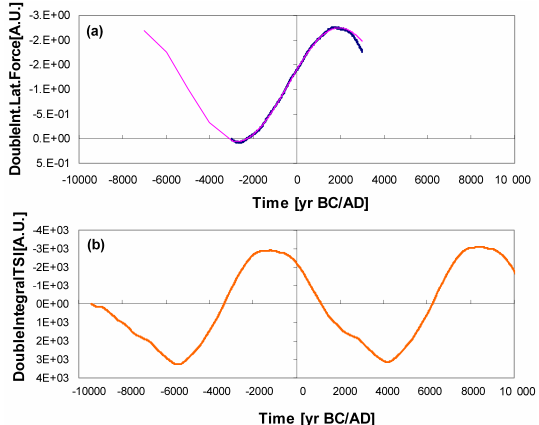
Figure B1. (a) Lateral forces on the Sun generated by planetary gravitational forces (PGF), expressed in [arbitrary units], evaluated by the Horizon/NASA system from 3000BC to AD3000. (b) The solar activity (TSI) expressed in [Wm − 2 ], average values of the three reconstructed records over the last millennia and extrapolated for the next millennia (10000BC to AD12000) based on ∼ 9500- year recurrence (records shown in Fig. 4a).